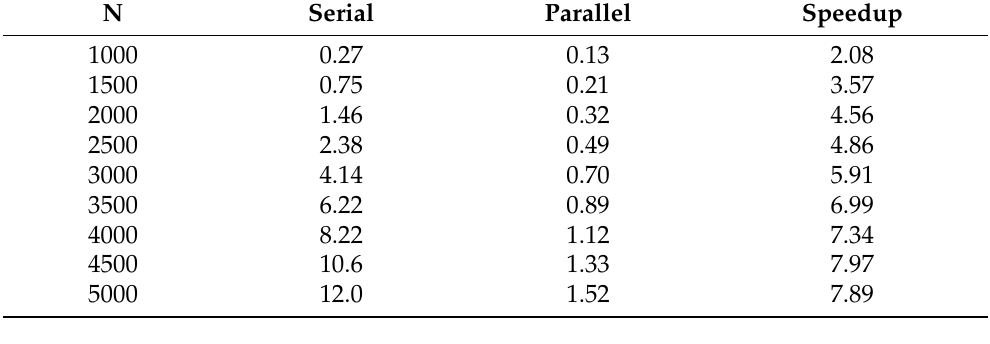
Table 1. Time in seconds and speedup for Intel Xeon X5570 and 32 OpenMP threads.